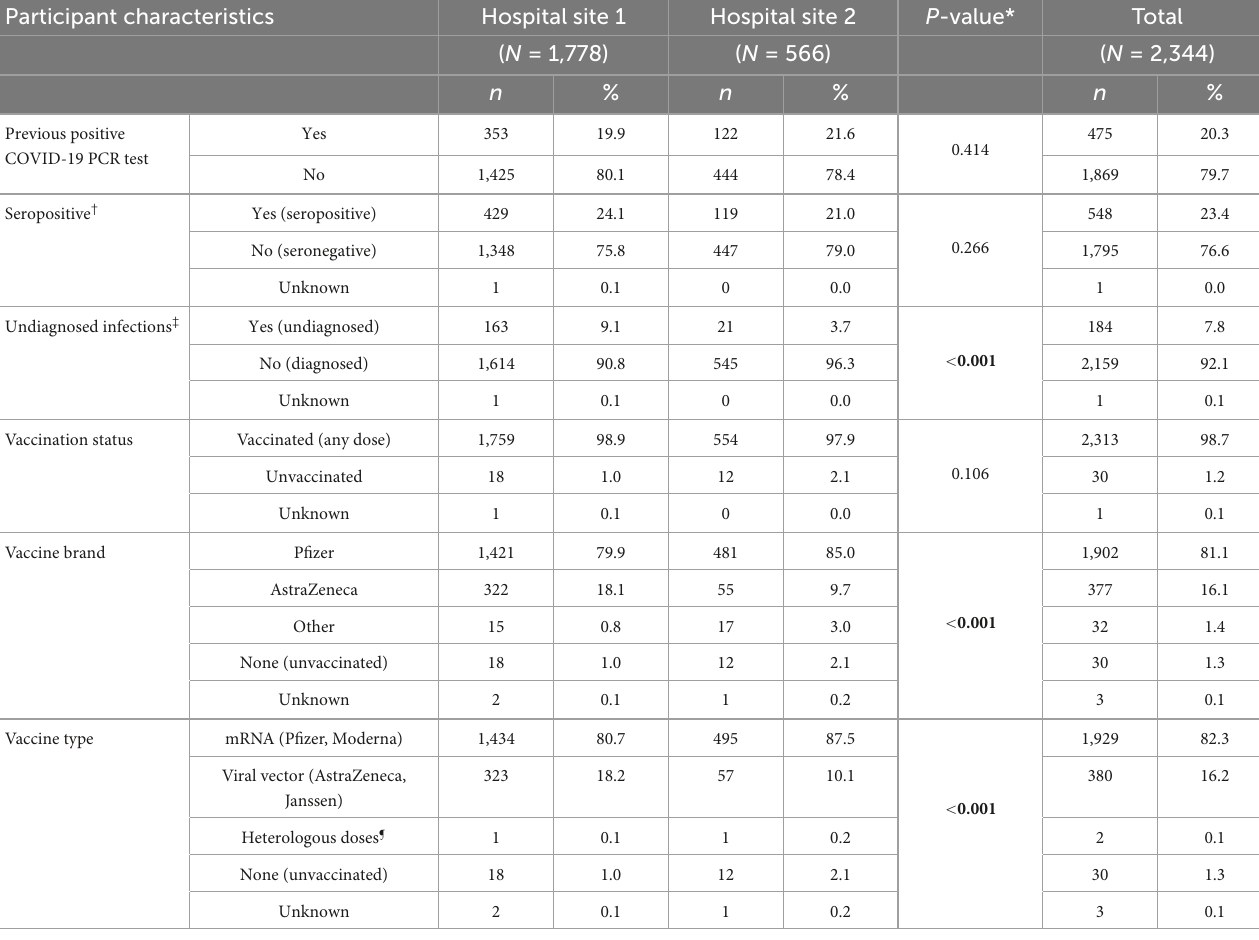
TABLE 1b COVID-19 related characteristics by hospital and total study population, PRECISE 4, Ireland, November 2021. Participant characteristics